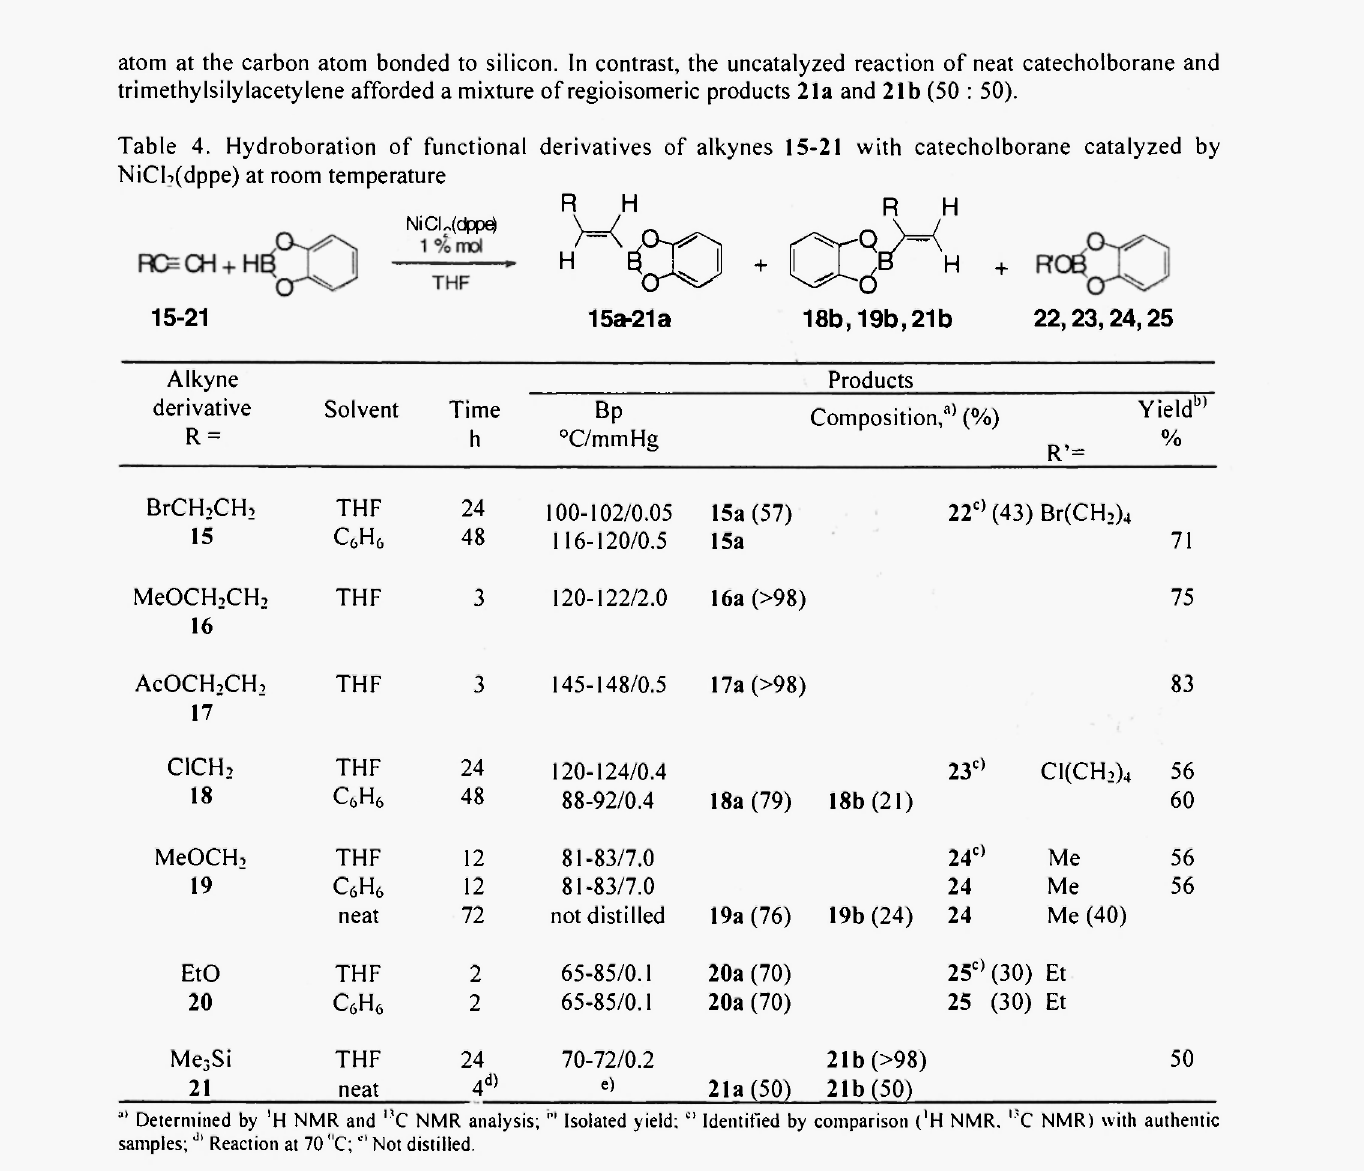
Table 4. Hydroboration of functional derivatives of alkynes 15-21 with catecholborane catalyzed by NiCI->(dppe) at room